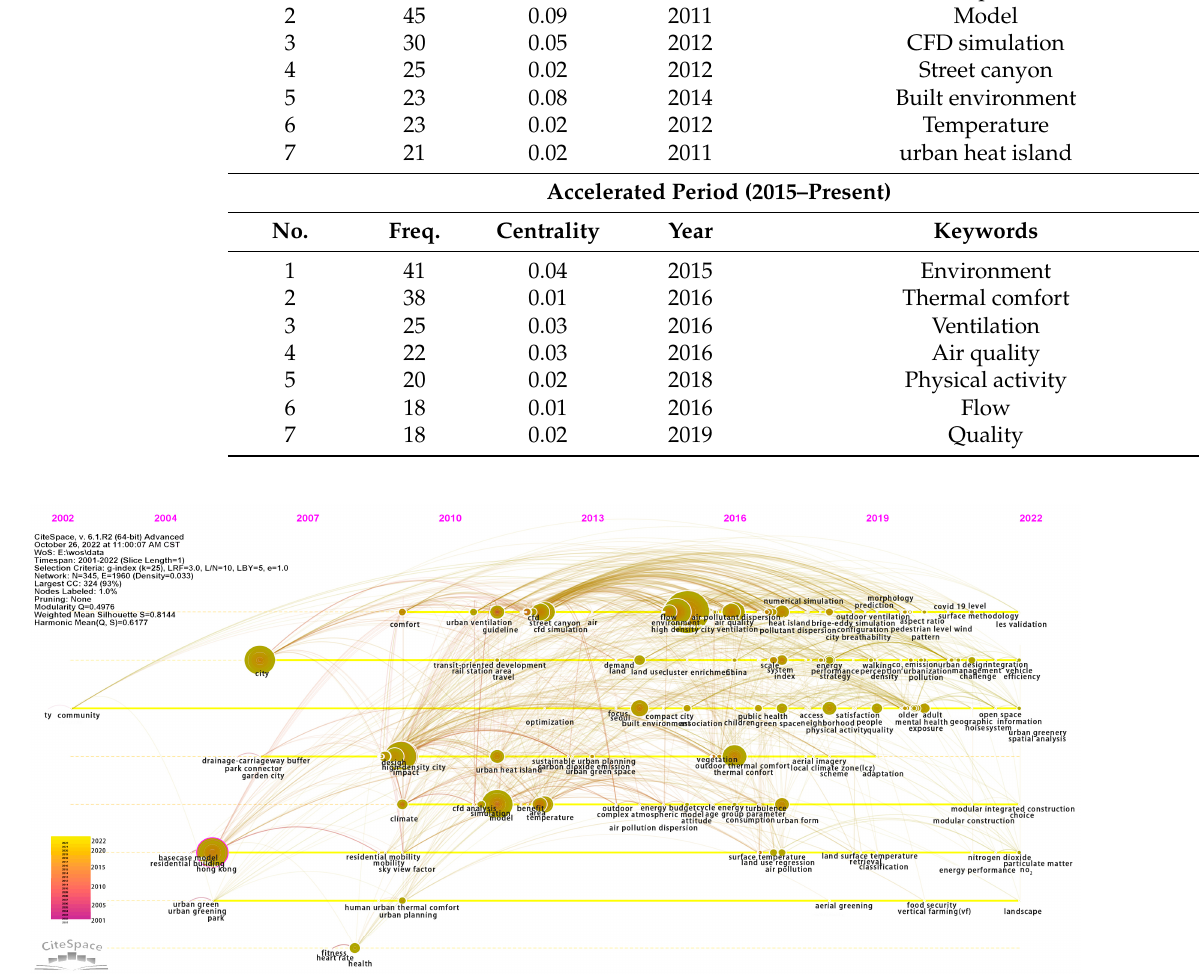
Figure 10. Co-occurrence time zones of high-density city research from 2001 to 2022.